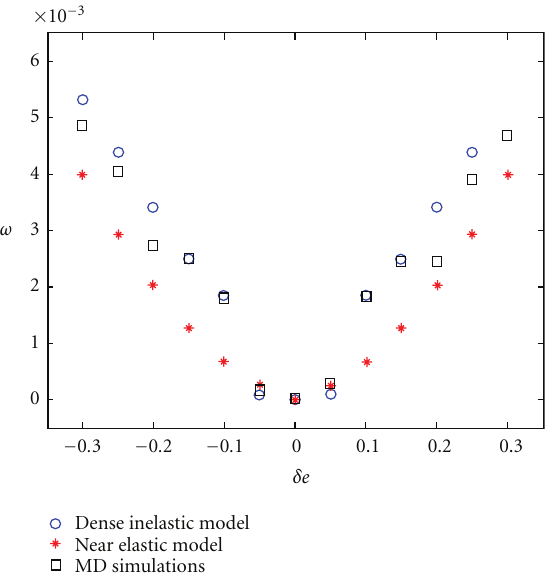
Figure 8: Comparison of angular velocity of convective roll for near elastic and dense inelastic models with MD simulations for V ∗ = 3 .